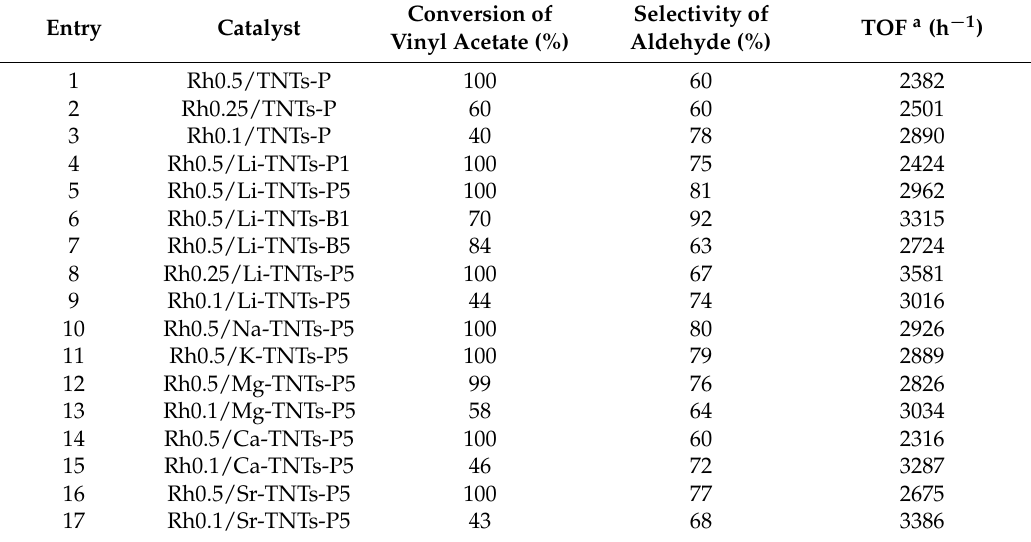
Table 2. Activity and selectivity of all catalysts catalyzed vinyl acetate